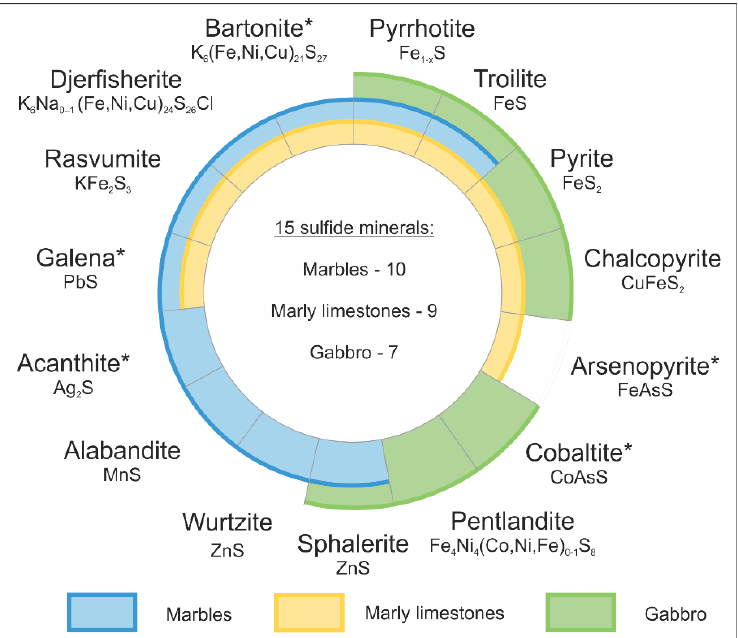
Figure 7. Mineralogical diversity of sulfide minerals in marbles, recrystallized marly limestones and gabbro from the Kochumdek contact aureole. * = small single grains.